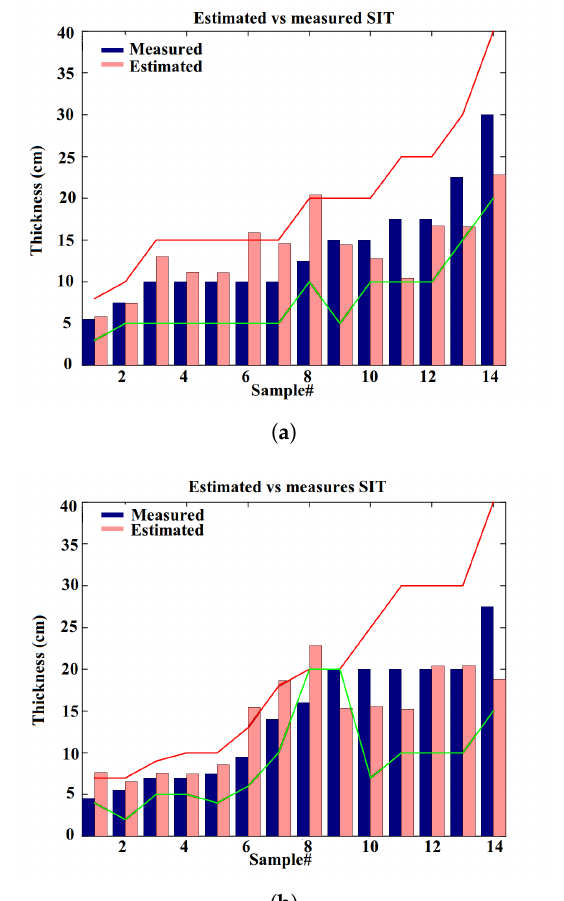
Figure 15. Sea ice thickness estimation result for ( a ) the training data set; and ( b ) for the test data set. The reference data is ordered in ascending order. R 2 = 0.71 and RMSE = 4.13 cm for the training data set, and R 2 = 0.74 and RMSE = 4.16 cm for the test data set. The lower and upper values of the ice thickness range are indicated by the green and red curves,